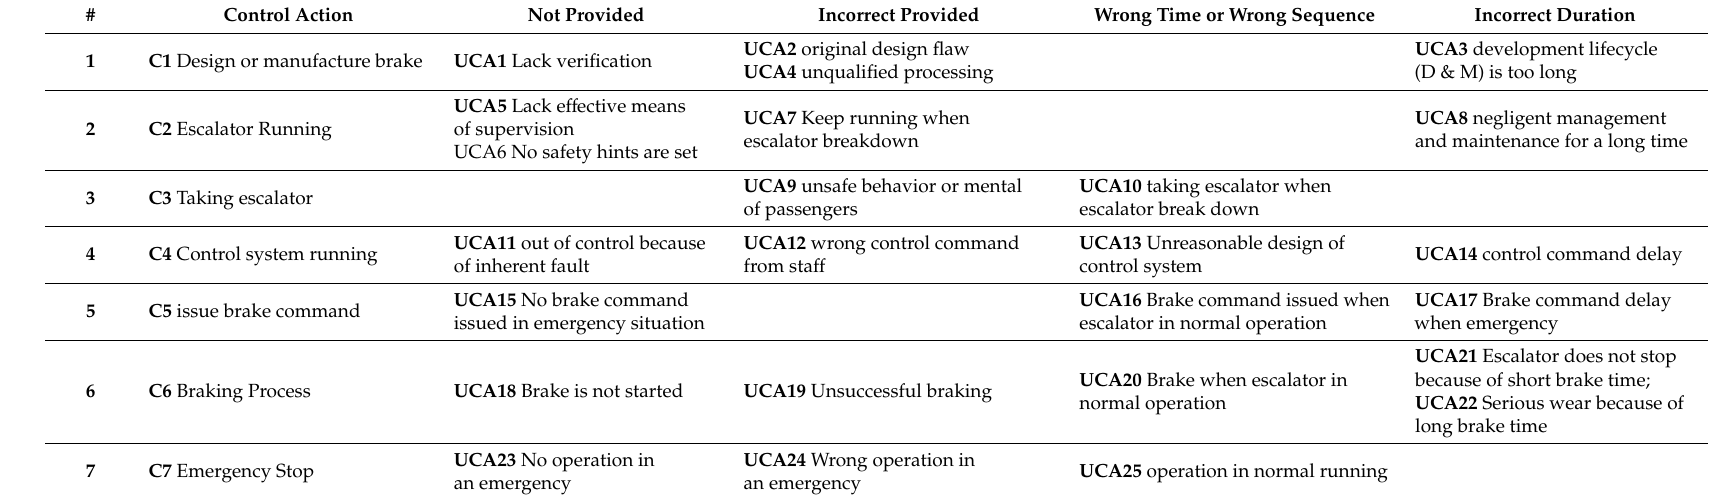
Table 5. Potentially hazardous control actions in Level 1.